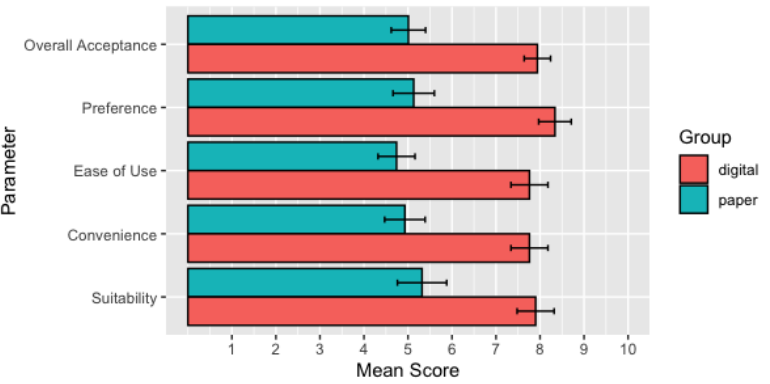
Figure 8. Group comparison of acceptance criteria of a digital compared to a traditional paper-based screening for accessing psycho-social distress in cancer patients and relatives on a scale from 0 (bad) to 10 (good). The study participants were randomly allocated to groups either processing a digital screening on a smart mobile device or a traditional paper-based screening. All group differences are statistically significant ( p < 0.01) and error bars in the plot describe standard